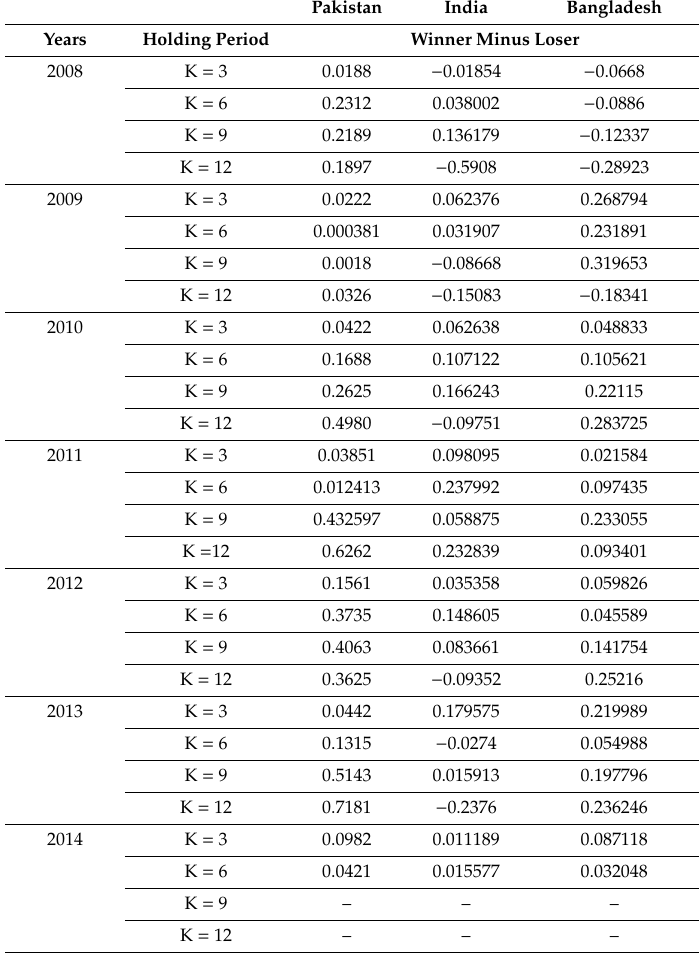
Table 1. Returns from momentum strategy for the di ff erent holding periods. Pakistan India